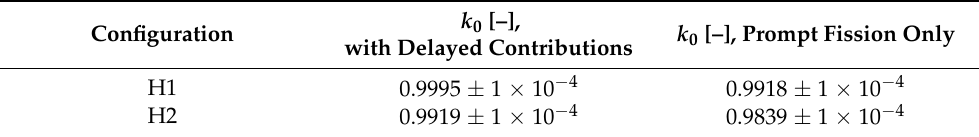
Table 18. Fundamental eigenvalues k 0 for H1 and H2 configurations of the CROCUS reactor.